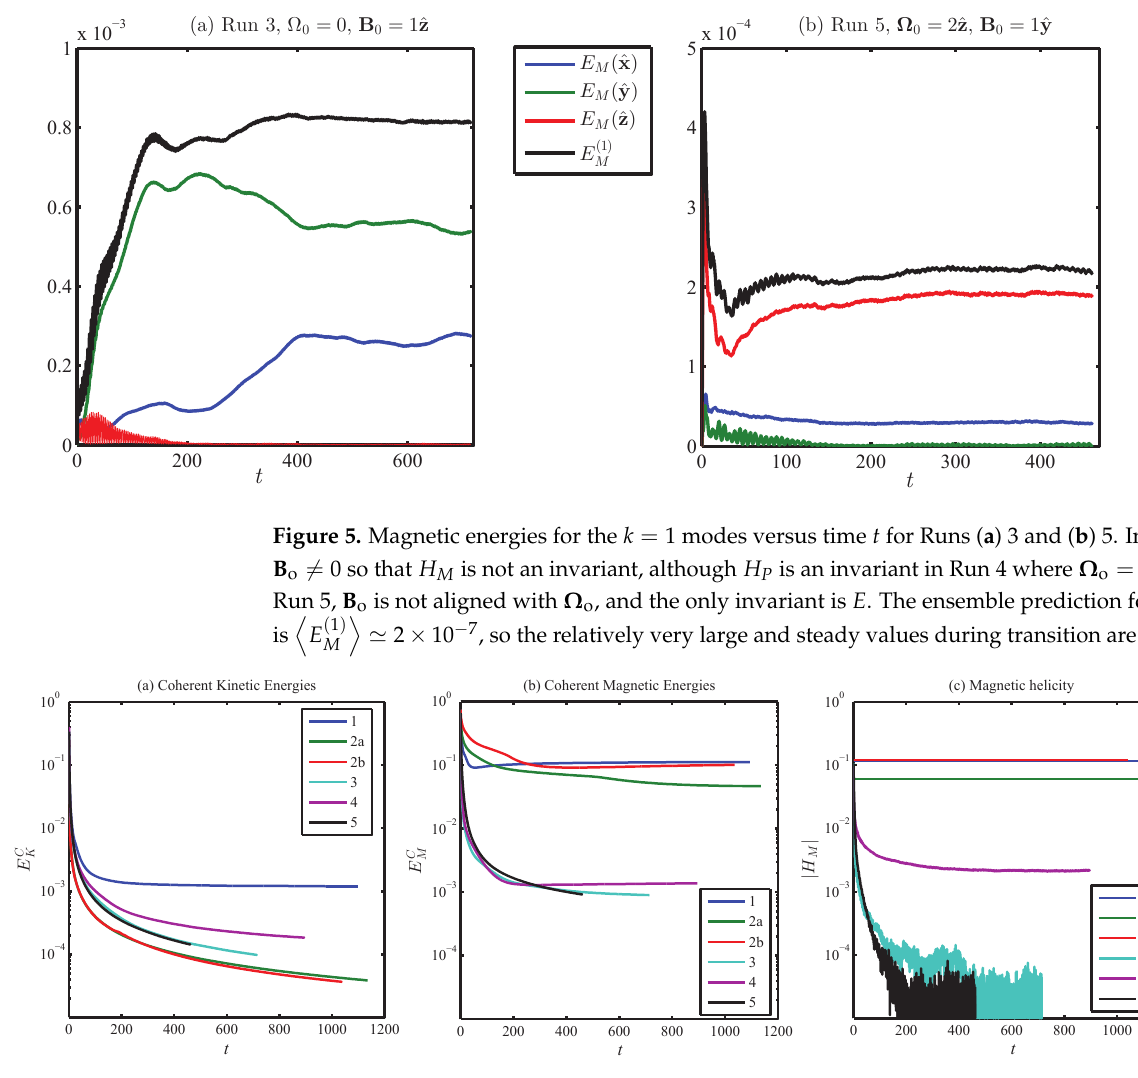
Figure 6. Coherent ( a ) kinetic and ( b ) magnetic energies compared to ( c ) total magnetic helicity versus time t for all runs. In ( a ), a constant coherent E K has only appeared in Run 1, while in ( b ) Runs 1, 2a, 2b and 4, constant coherent E M have evolved and in ( c )—constant H M , with E M indicated in Figure